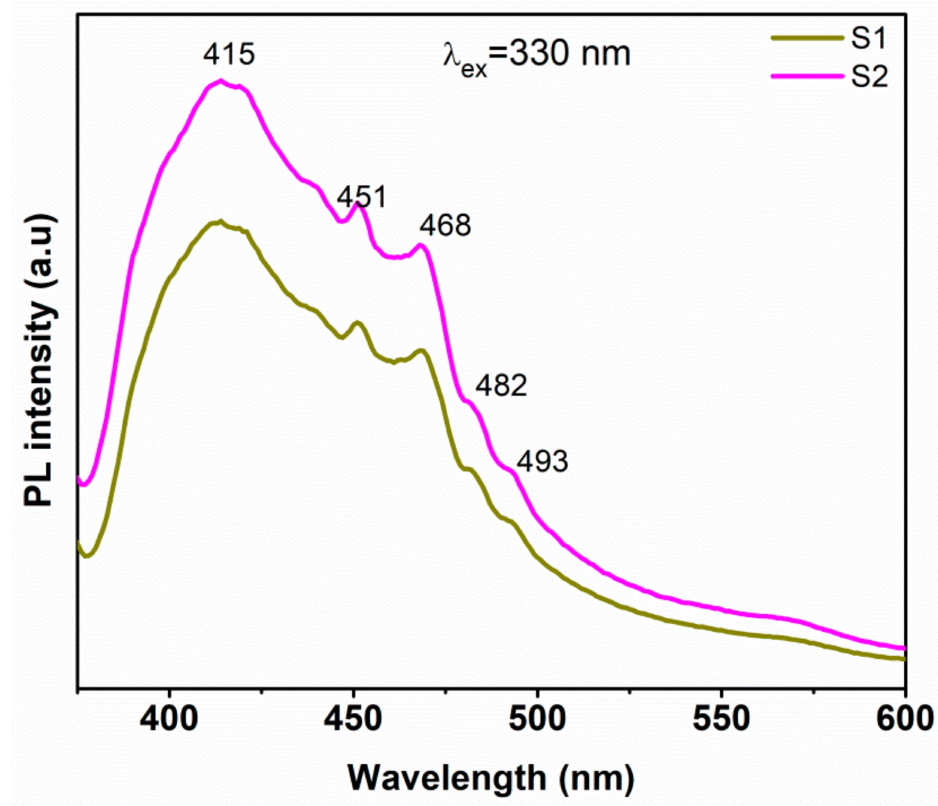
Figure 6. Photoluminescence spectra of ZnO/graphene nanocomposites excited at 330 nm. The mechanism of ZnO/graphene’s photocatalytic activity on MB dye in sunlight is schematically depicted in Figure 7. In the dark, initially, the MB dye molecules are adsorbed on the surface of the ZnO/graphene nanocomposite by means of electrostatic interaction and π - π interaction with the carbon atoms of graphene. After sunlight irradiation, the electrons in the valence band (VB) of ZnO are excited to the conduction band (CB) and created an effective number of photo-generated electron-hole pairs. Then, the electrons in the CB of ZnO and the delocalized electrons in graphene react with the oxygen atoms in the dye solution and produce oxy radicals. Meanwhile, oxy radicals and holes in the VB react with the H 2 O molecules and produce hydroxyl radicals. These reactive hydroxyl radicals degraded the dye molecules into non-toxic molecules [60,61]. According to the PL spectra, the defect energy level in ZnO traps excited electrons and reduces the formation of electron-hole pairs, supporting improved dye degradation. Due to the slightly higher energy level ( − 4.05 eV) of the conduction band of ZnO than the work function of the graphene sheet ( − 4.42 eV), the electrons in the CB of ZnO readily transferred to the graphene and the electrons are involved in the dye degradation [62]. The presence of graphene nanosheets with ZnO increases the degradation efficiency as it improves the transportation and separation of photogenerated electron-hole pairs and their lifetime at the semiconductor/solution interface. Moreover, the high surface area of graphene nanosheets provides a desirable interfacial hybridization with ZnO. Hence, the overall dye degradation is expected to be improved after the incorporation of graphene in ZnO